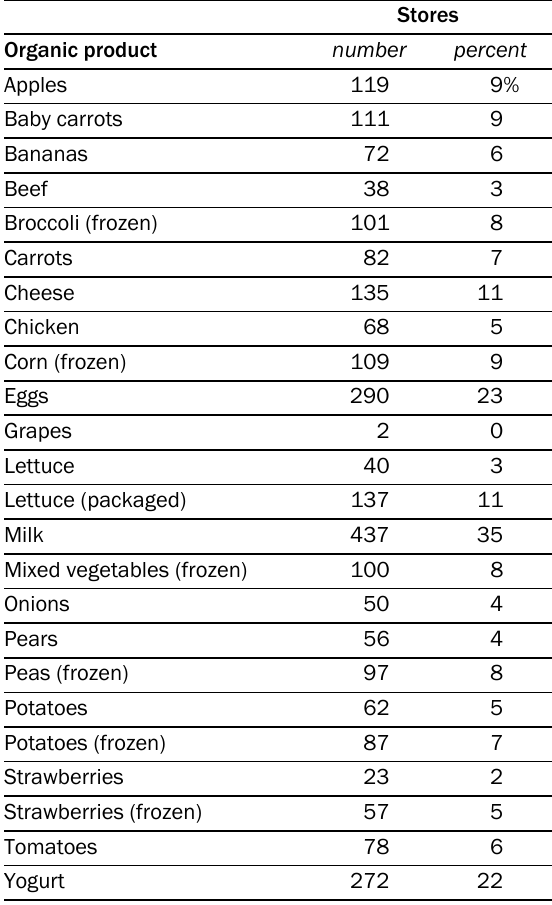
Table 1. Organic Food Availability,